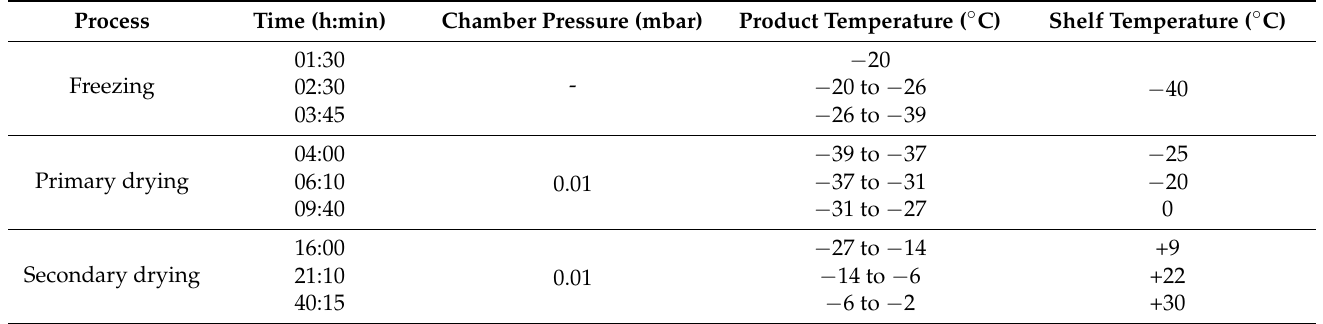
Table 1. Process parameters are taken into consideration during the process of